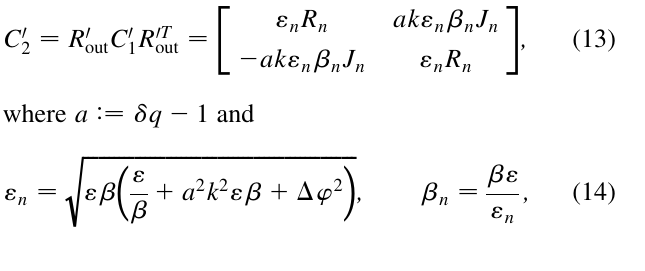
longitudinal magnetic field strength and the beam rms sizes on the stripper. Interplane correlations are created and the rms emittances and eigen-emittances after the solenoid with stripper foil read